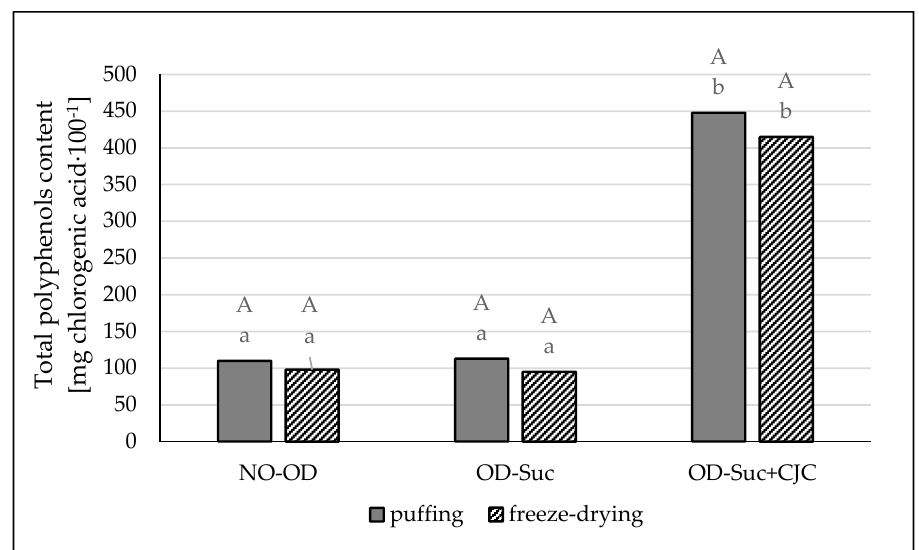
Figure 3. The influence of the type of osmotic solution and drying method on the total polyphenols content in apple samples: dried by “puffing” or freeze-drying way; no pre-treated (No-OD), pre-osmotic dehydrated in sucrose (OD-Suc) or in sucrose with chokeberry juice concentrate solution (OD-Suc + CJC). The same letter, a, b, c indicates a lack of statistically significant differences in the type of osmotic solution and A, B in the drying method.